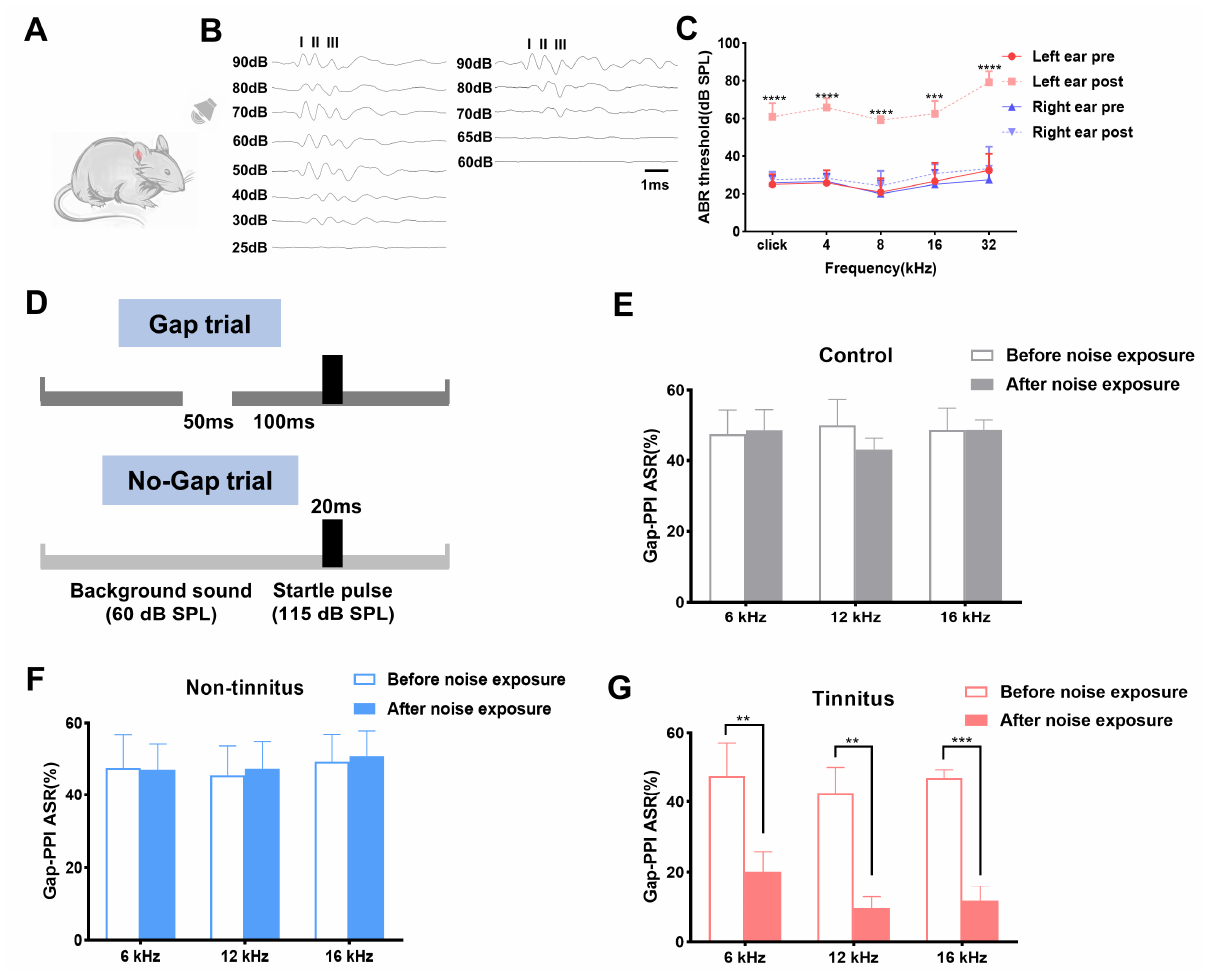
Figure 1. Establishment of noise-induced tinnitus rat model. ( A ) Schematic figure of the experimental setting. ( B ) Typical image of click-ABR threshold of the left ear before ( left ) and after the noise exposure ( right ). ( C ) Click-ABR and pure tone-ABR threshold of both ears before and after the noise exposure. ( D ) The experimental paradigm set in the current work detecting tinnitus. ( E , F ) Graphs of Gap-PPI before and after noise exposure for background sounds at 6, 12, 16 kHz in the control and non-tinnitus group (n = 6). ( G ) Graphs of Gap-PPI before and after the noise exposure for background sounds at 6, 12, 16 kHz in the tinnitus group. n = 6. ** p < 0.01, *** p < 0.001, **** p < 0.0001, bar = 1 ms. ABR: auditory brainstem response; PPI: pre-pulse inhibition.